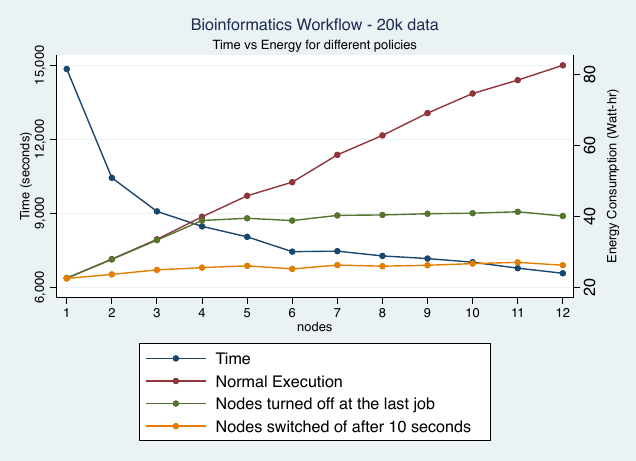
Figure 20. Time vs. Energy for Bioinformatics workflow as per different